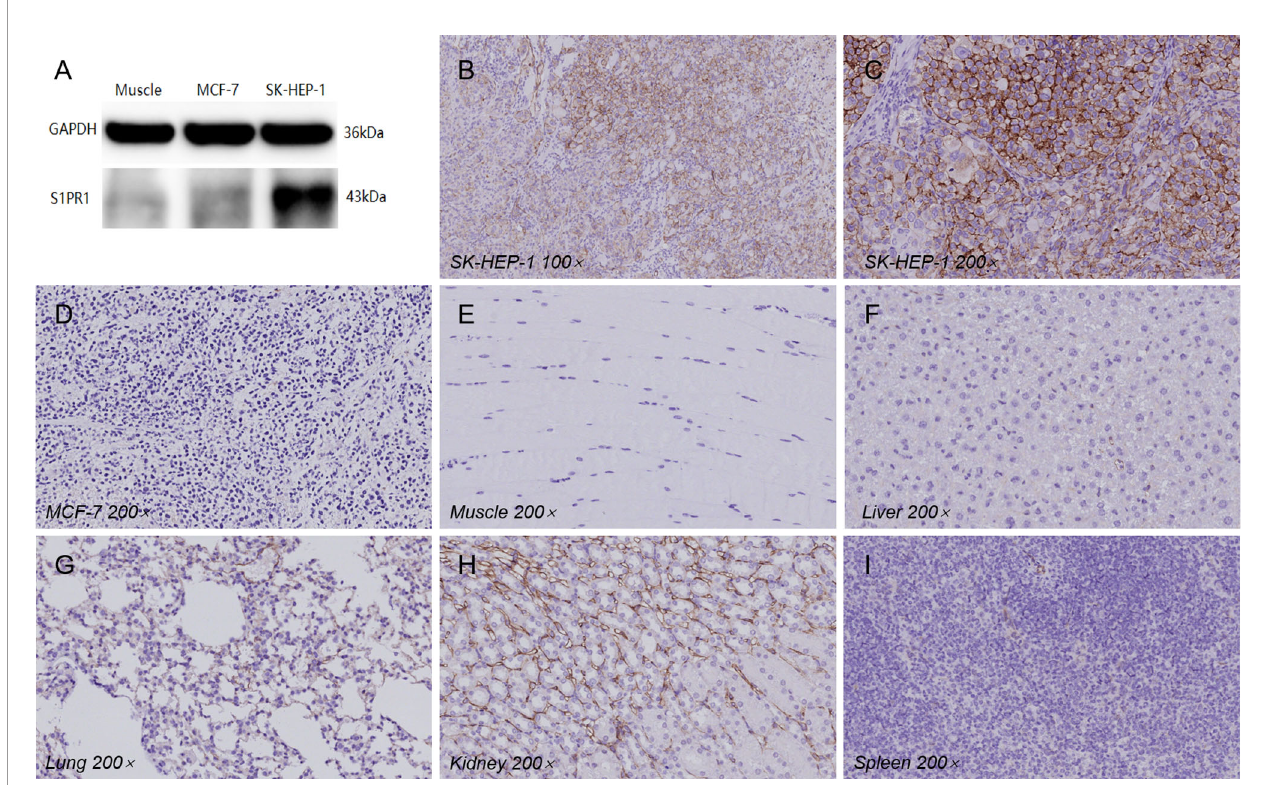
FIGURE 4 | (A) Western blot analysis of S1PR1 expression in SK-HEP-1, MCF-7 tumor tissues and muscle. (B – I) The immunohistochemical staining results of various organs and tissues (under 100× and 200× magni fi